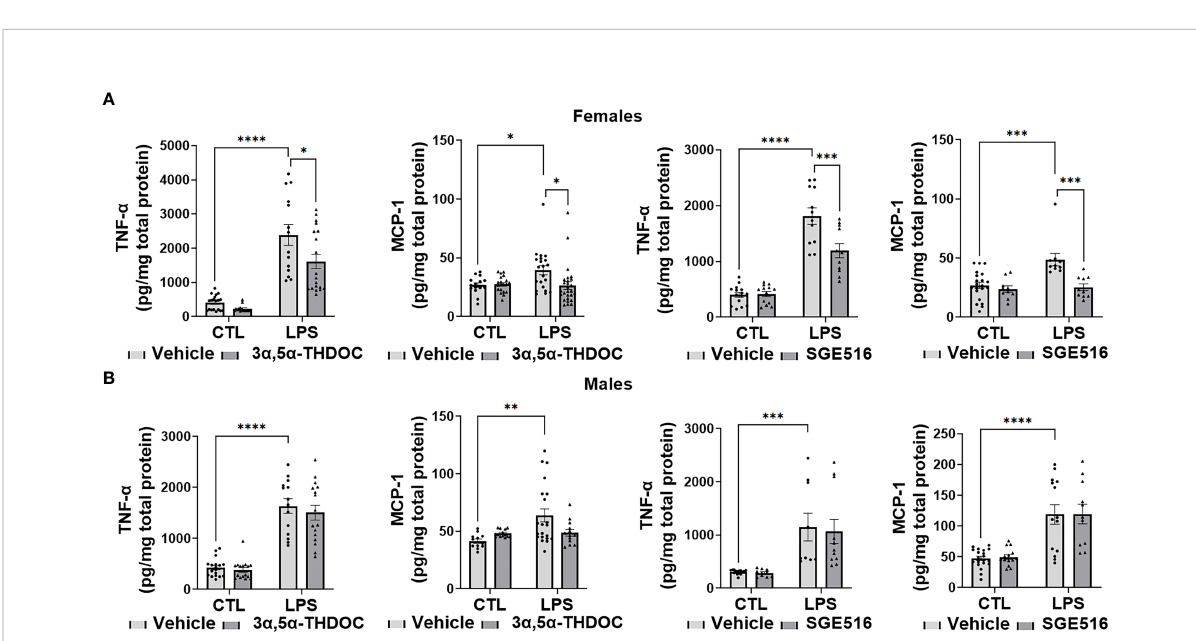
FIGURE 4 3 a ,5 a -THDOC and SGE-516 inhibit LPS-induced increases of TNF- a and MCP-1 in human monocyte-derived macrophages (hMDM) from female, but not male donors. Each hMDM culture (n ≥ 12 from 3 female (A) or 3 male (B) donors/grp) is shown as a single symbol. Cells were treated with LPS (1µg/ml; 24h) with or without 3 a ,5 a -THDOC (1µM; 24h) or SGE-516 (1µM; 24h). LPS caused a signi fi cant increase in the levels of TNF- a (~80% in hMDM from both female (A) and male (B) donors) and MCP-1 (~65% in hMDM from both female (A) and male (B) donors) relative to vehicle control (CTL). The increases of TNF- a were partially inhibited by 3 a ,5 a -THDOC and SGE-516 (~30% and ~35% inhibition, respectively) in hMDM derived from female (A) but not male (B) donors. The increases of MCP-1 were completely inhibited by 3 a ,5 a -THDOC or SGE-516 in hMDM from female (A) but not male (B) donors. Two-way ANOVA, Tukey ’ s post hoc test: *p<0.05, **p<0.01, ***p<0.001, ****p<0.0001.